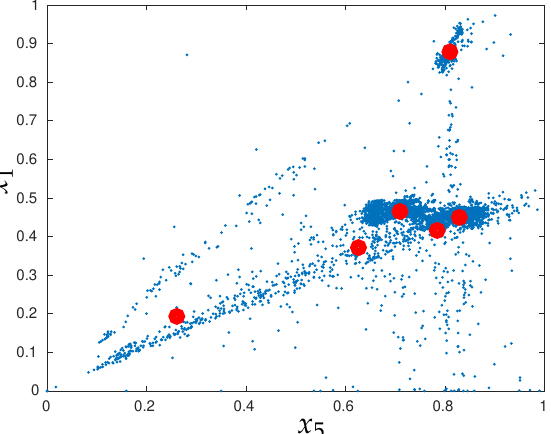
Figure 2. (Blue Dot): Scattered plot of variables x 5 , x 1 samples; (Red Circles) the projection of the mean values (cid:126) µ k calculated by EM algorithm.